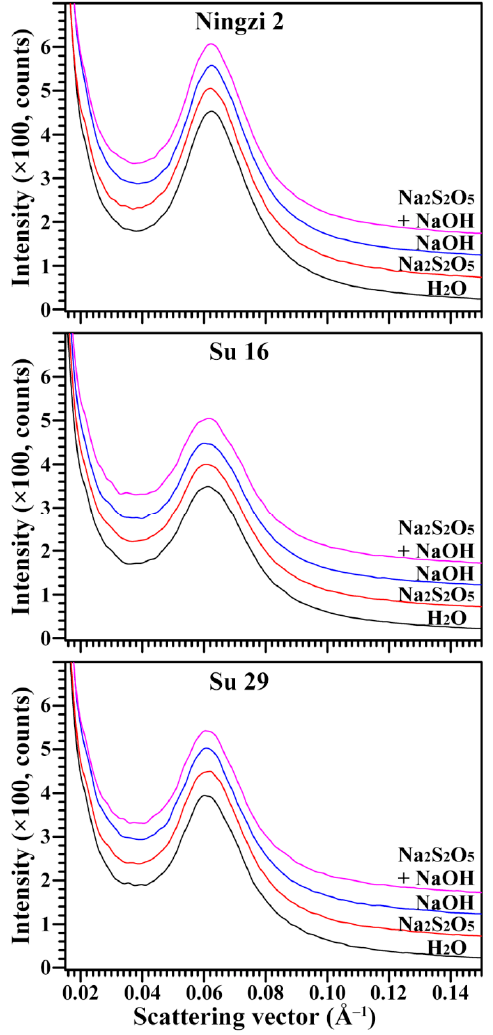
Figure 6. SAXS patterns of starches.